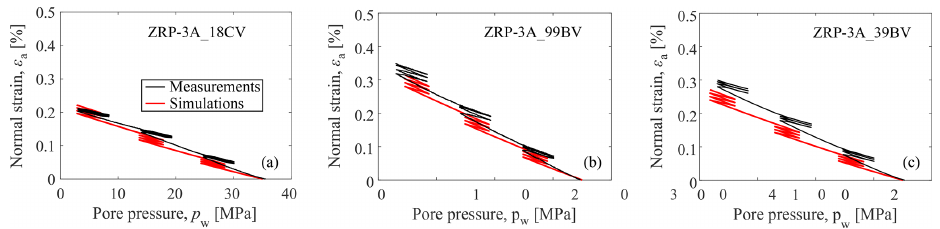
Figure 1. Simulations of the UPPD/M tests with two end-member porosities (test ID: ZRP-3A_18CV and ZRP-3A_39BV) and the medium porosity (test ID ZRP-3A_99BV). Table 1. Summary of model parameters typical in the Groningen gas